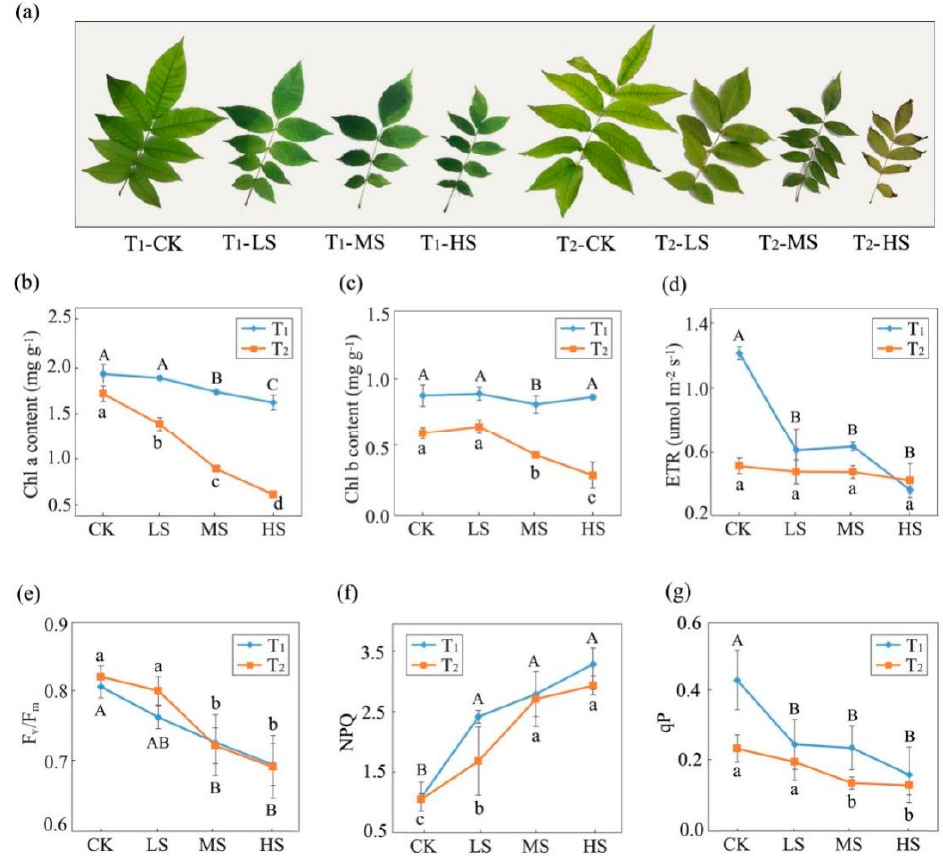
Figure 1. C. paliurus seedlings under different salt treatments at two sampling times. ( a ) Phenotypes, ( b , c ) chlorophyll content, and ( d – g ) fluorescence characteristic. Capital and lower-case letters represent significant differences among treatments at T 1 and T 2 , respectively. T 1 , T 2 represent two sampling times (15 and 30 days after treatments). CK, LS, MS and HS represent four NaCl treatment levels (control, 0.15%, 0.30% and 0.45%, m/v ).